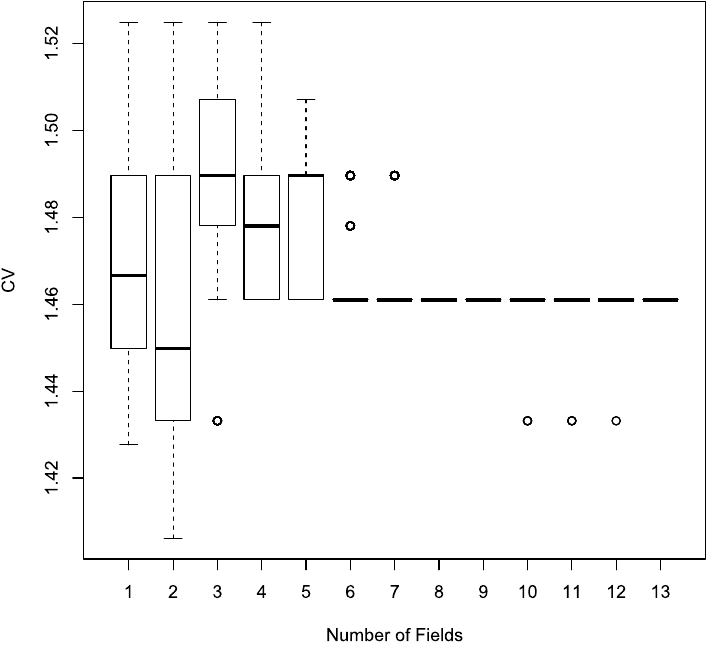
Fig 5. Coefficient of variation. Distribution of the coefficient of variation by the number of fields used to calculate FRNA 50